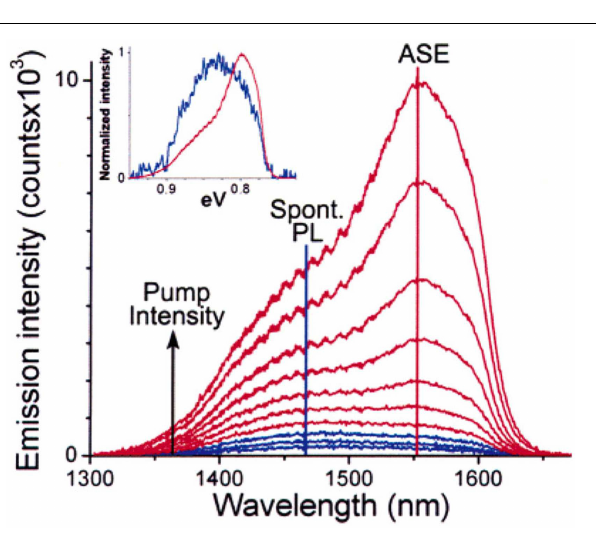
FIGURE 15 | Development of a spectrally narrowedASE band at 1555nm is observed as a function of pump power for PbSe QDs . Comparison of normalized emission spectra produced using low (blue) and high (red) pump intensities (inset), which are dominated by spontaneous PL and ASE, respectively, shows the ASE as a spectrally narrowed, red-shifted band (Schaller et al.,